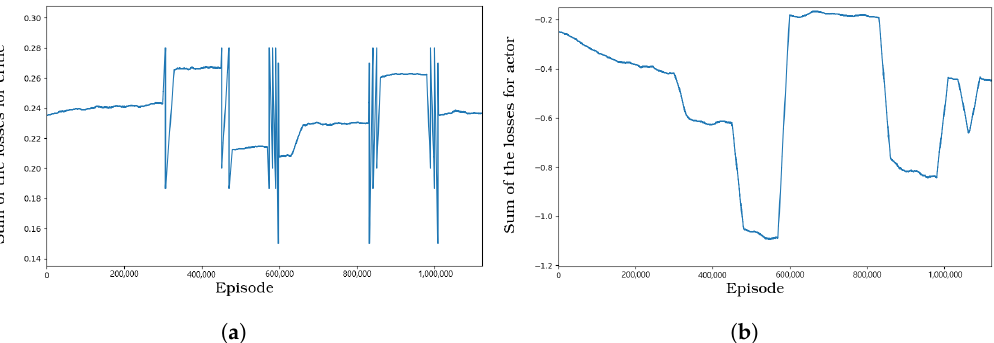
Figure 8. The loss values of ( a ) critic learning process and ( b ) actor learning process. We can observe great changes in the loss values in a couple of places over the graph—this is related to resetting of the “recent policy” network used in the PPO technique. Despite that, the absolute loss values are still smaller than the ones observed in the A2C implementation; they appear to be highly variated due to 4 smaller absolute values of the